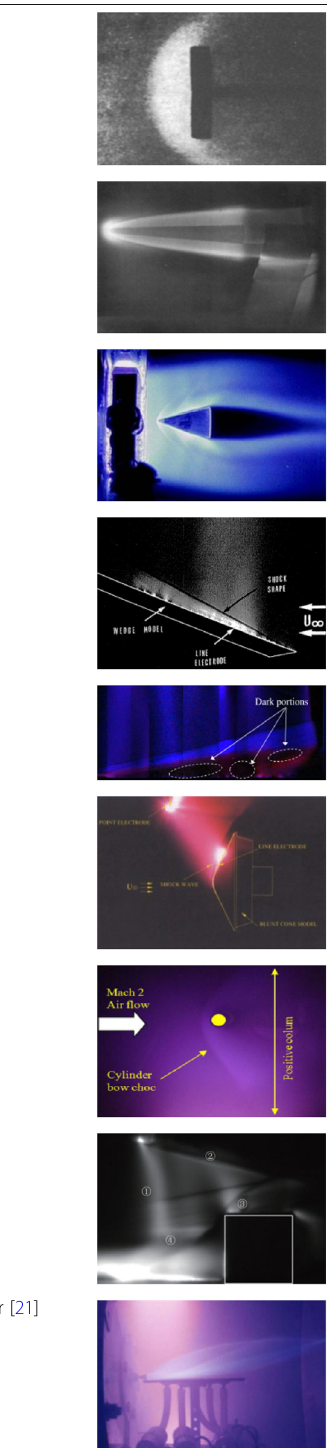
Table 1 Review of electric glow discharge applications in rarefied flows